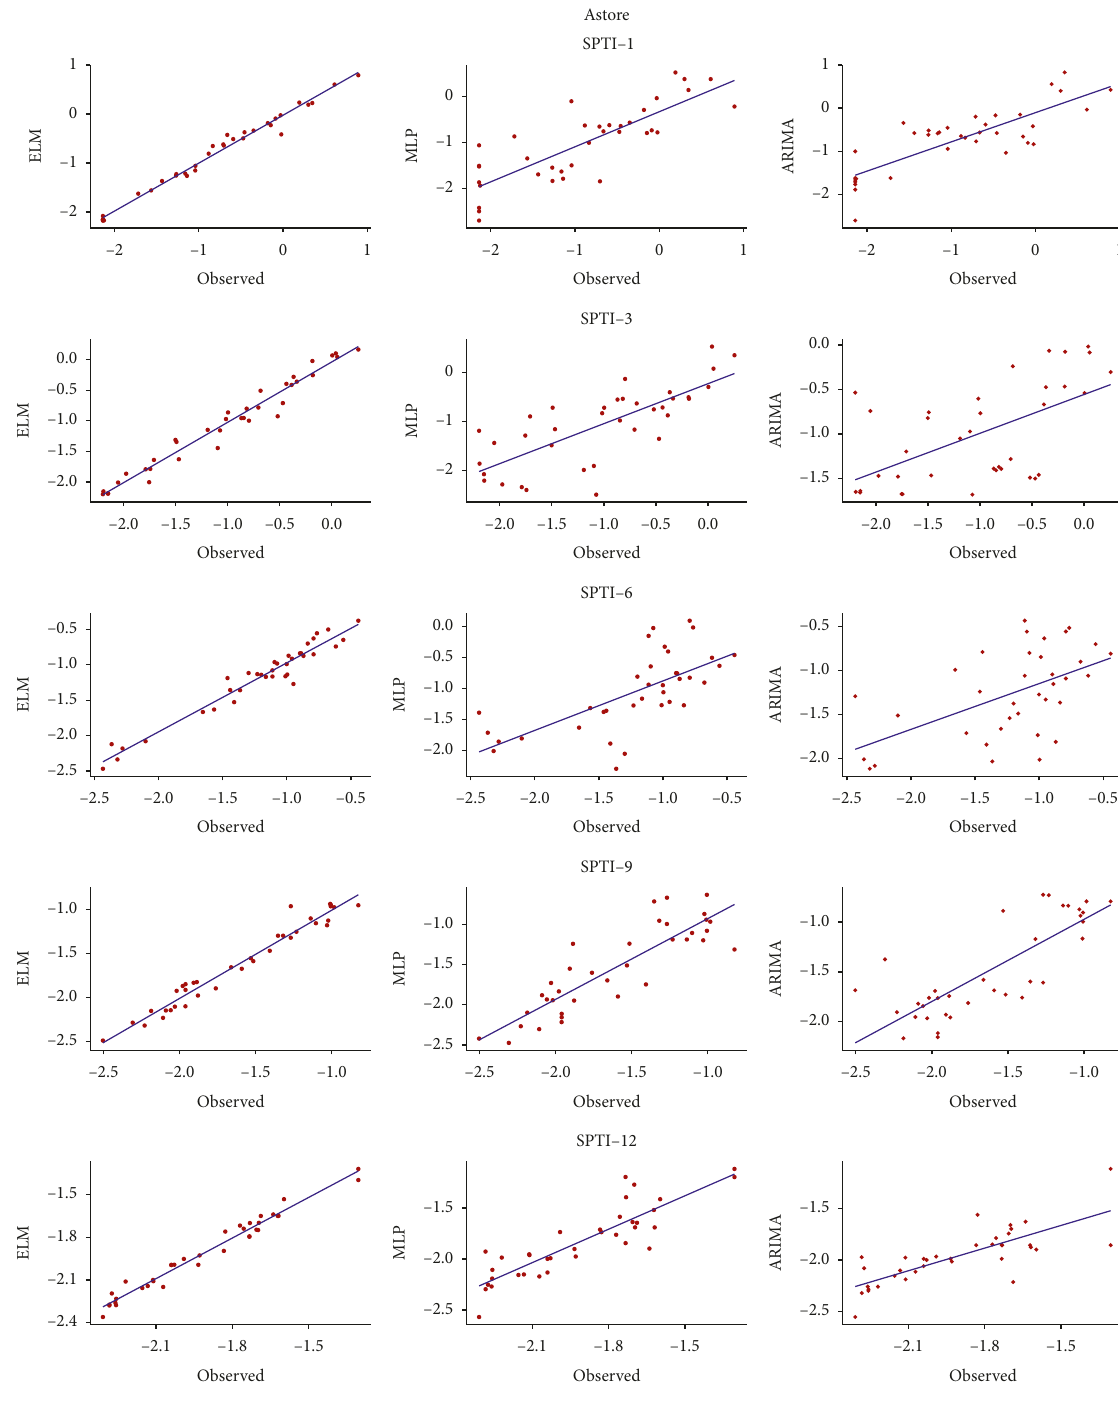
Figure 14: Scatter plots of the observed and forecasted values of SPTI using ELM, MLP, and ARIMA models at Astore station with all lead time scales for the test phase. The least-squares regression line is also